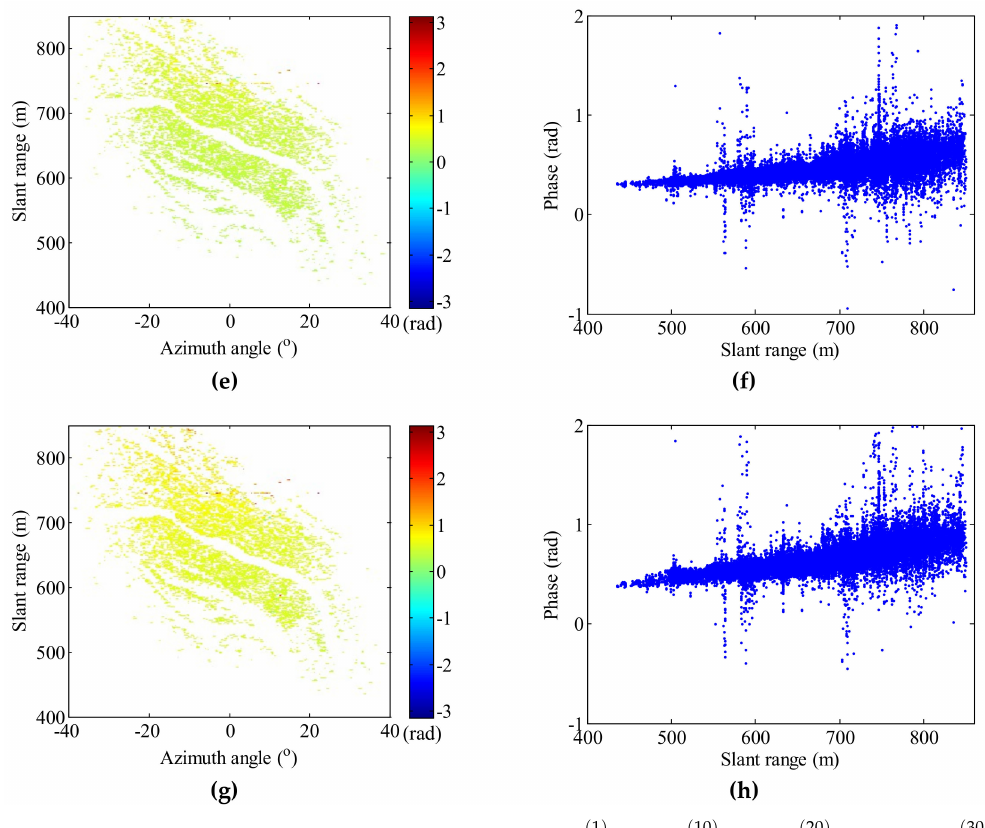
Figure 5. Four phase interferograms of Group A: ( a ) IM Corresponding scatter diagrams: ( b ) SD